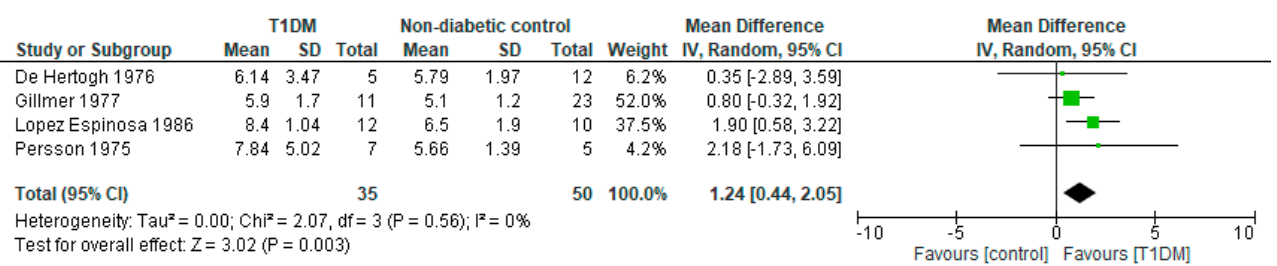
Figure A1. Meta-analysis of hPL levels in T1DM vs. non-diabetic control women in late pregnancy (>24 weeks)—4 studies.